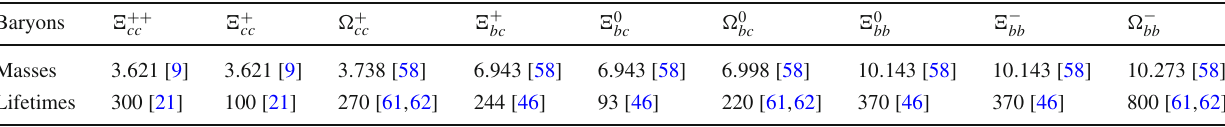
Table 2 Masses (in units of GeV) and lifetimes (in units of fs) of doubly heavy baryons. We have used the experimental data for the mass of (cid:4) ++ cc [9] and theoretical results from Refs.